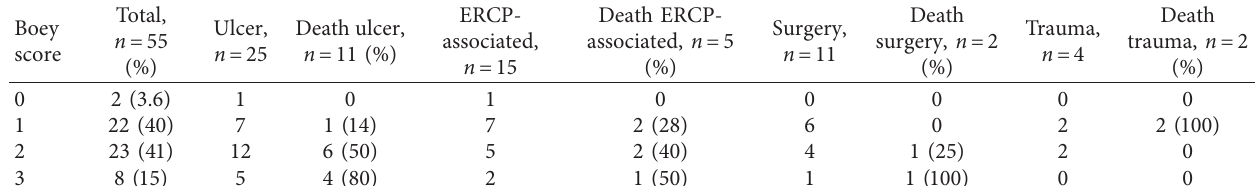
Table 4: Boey score with mortality in each aetiology group.